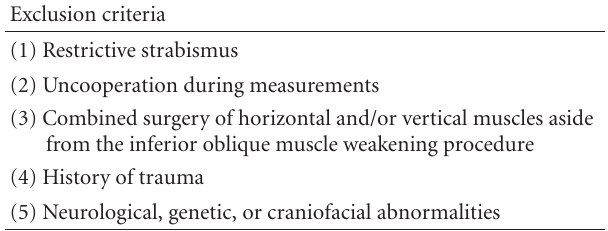
Table 1: The exclusion criteria of the study. Exclusion